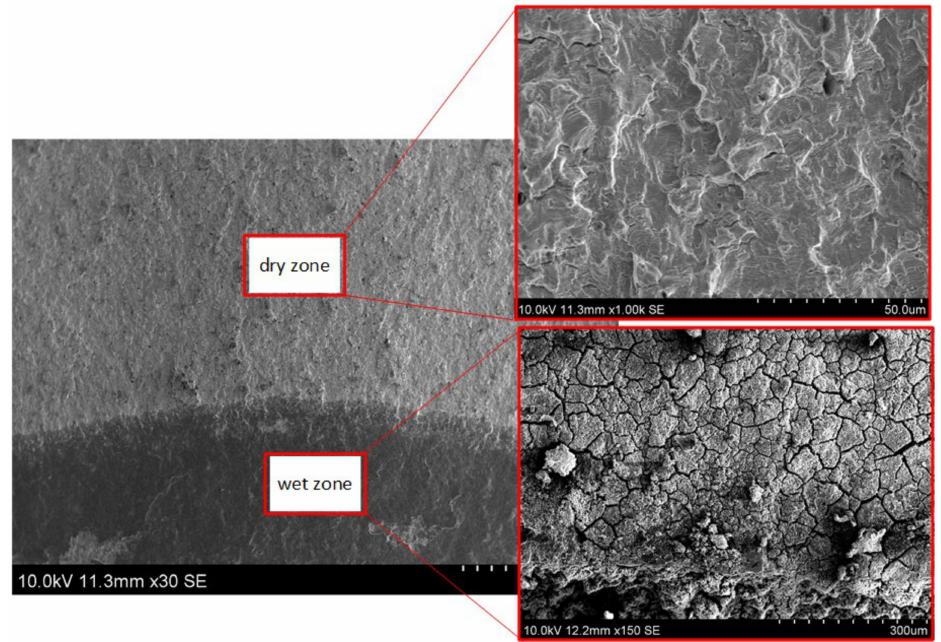
Figure 14. SEM macroscopic view on the “wet” and “dry” zone of crack propagation mechanism in specimens tested with fluid